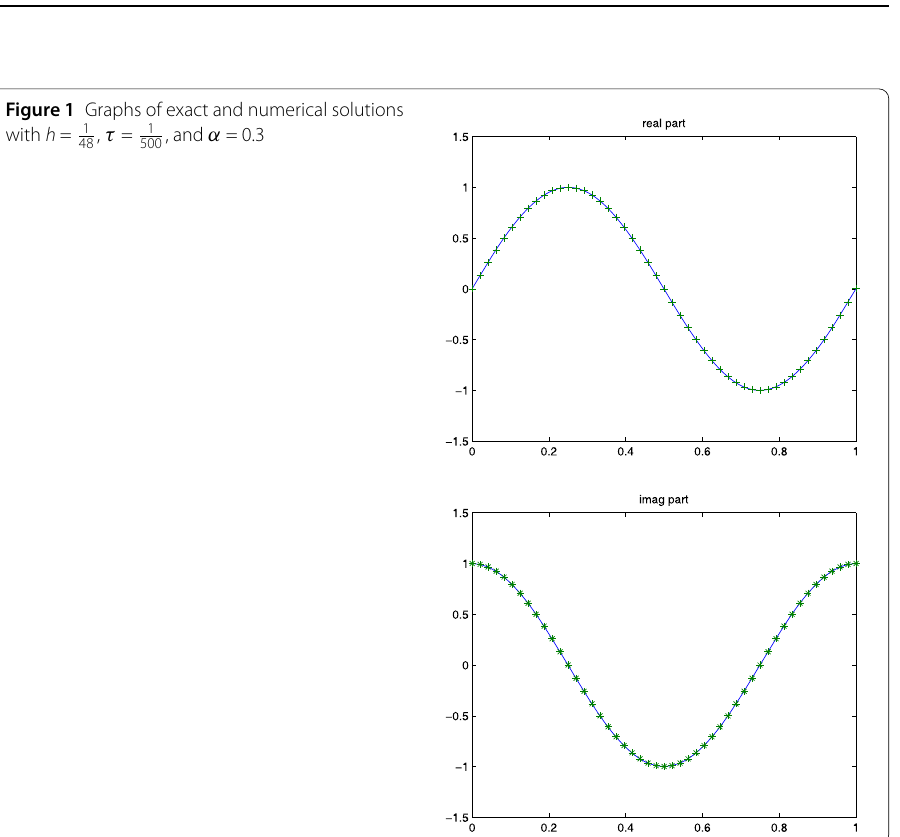
Figure 1 Graphs of exact and numerical solutions with h = 1 , τ = 1 , and α = 48 500